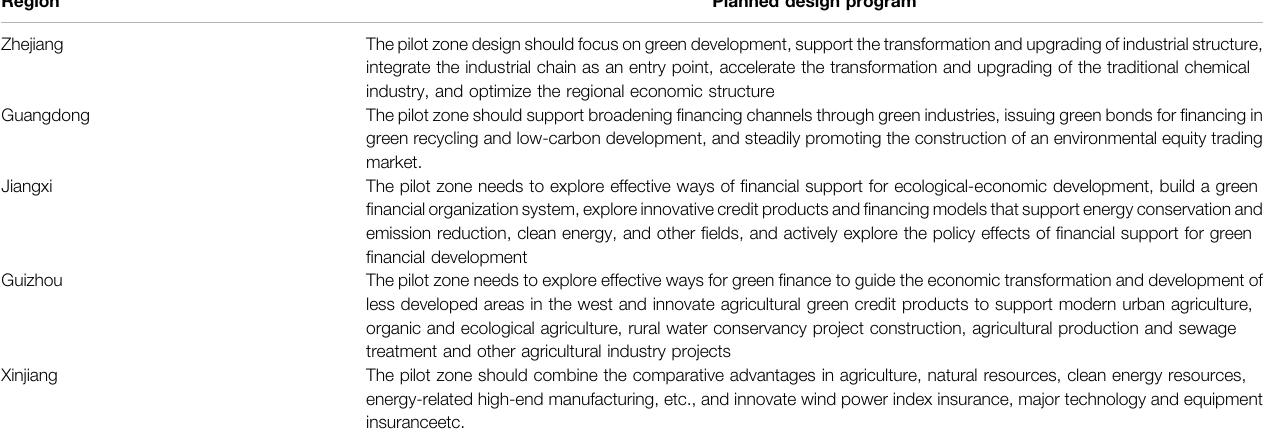
TABLE 1 | Comparison of pilot zones for green fi nance reform and innovation. Region Planned design program